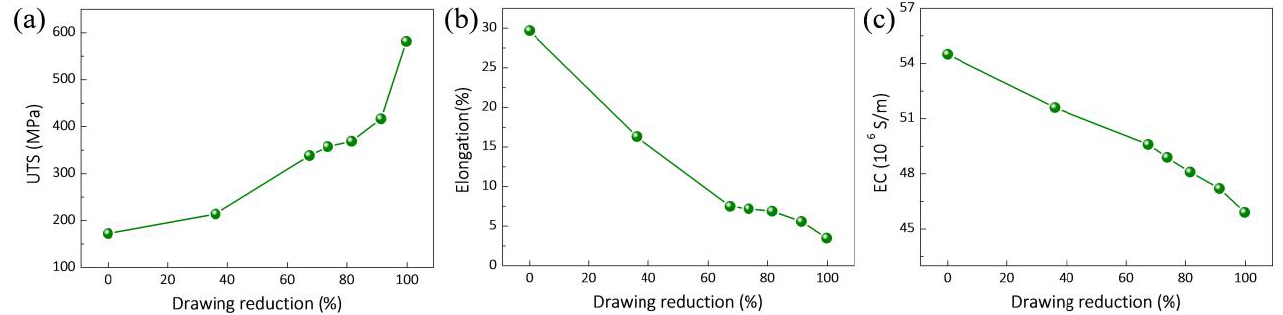
Figure 15. Tensile properties and electric properties of composites with different drawing reductions: ( a ) UTS, ( b ) elongation and ( c ) electrical conductivity (EC).